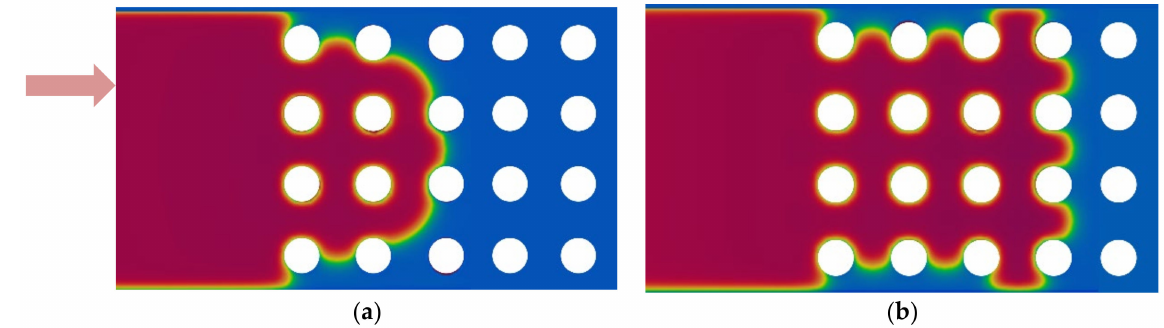
Figure 8. CO 2 displacement process at body force 4.5 × 10 − 5 with a stable displacement pattern. The same color scheme is used, as in Figure 6. ( a ) 63,700 ts. ( b ) 186,900 ts.